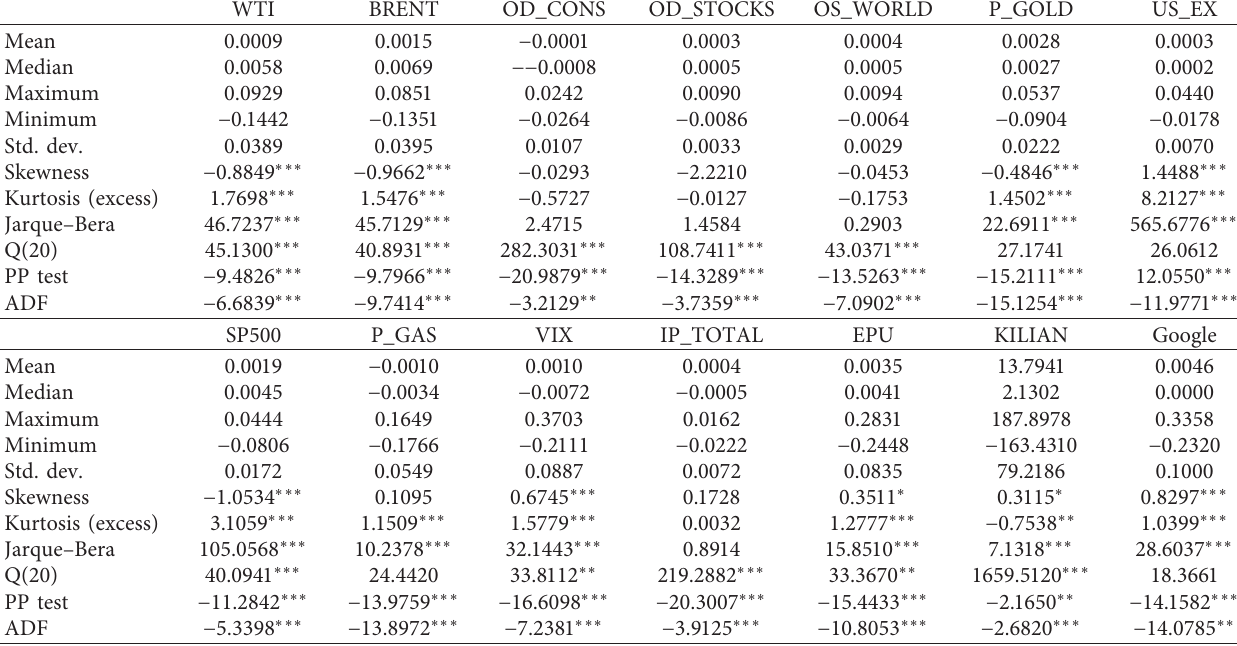
Table 2: Descriptive statistics.